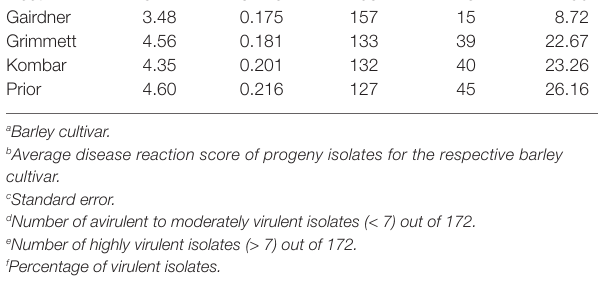
a Barley cultivar. b Average disease reaction score of progeny isolates for the respective barley cultivar. c Standard error. d Number of avirulent to moderately virulent isolates (< 7) out of 172. e Number of highly virulent isolates (> 7) out of 172. f Percentage of virulent